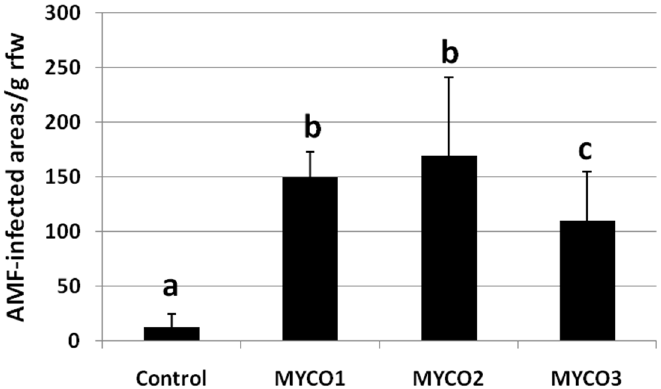
Figure 3. AMF-infected areas per g of root fresh weight (rfw) observed on KOH-lactophenol blue treated roots under a stereoscope. Roots were collected from plants untreated (Control) or treated with 3 doses of Myco at 28 dpt. Six different root samples were analyzed per treatment. Values are expressed as mean ( n = 6) ± standard deviation. Means were separated by Duncan’s test; different letters indicate significantly different means (significance level: 0.05).